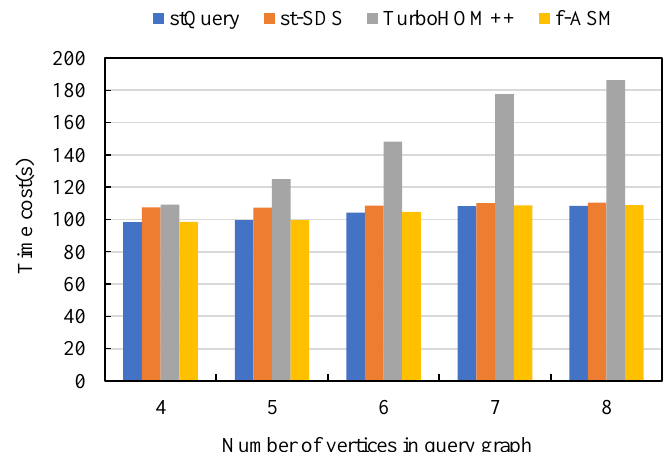
Figure 11. Experimental comparison of the star query pattern.